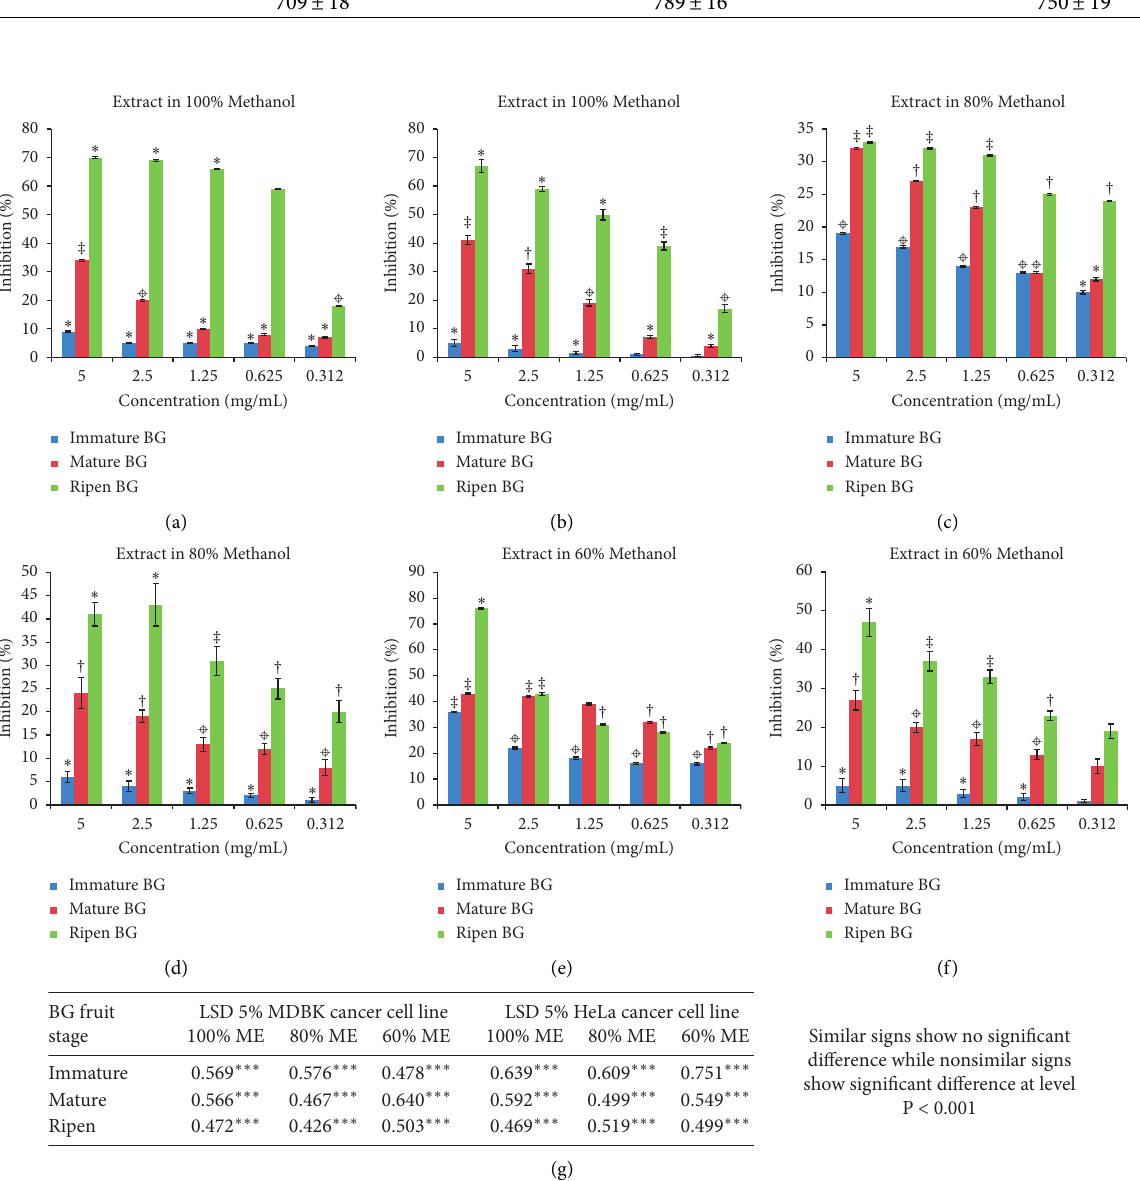
Table 3: IC 50 values of immature, mature, and ripen BG extracts in 60%, 80%, and 100% methanol against MDR S. aureus microorganism. Fruit